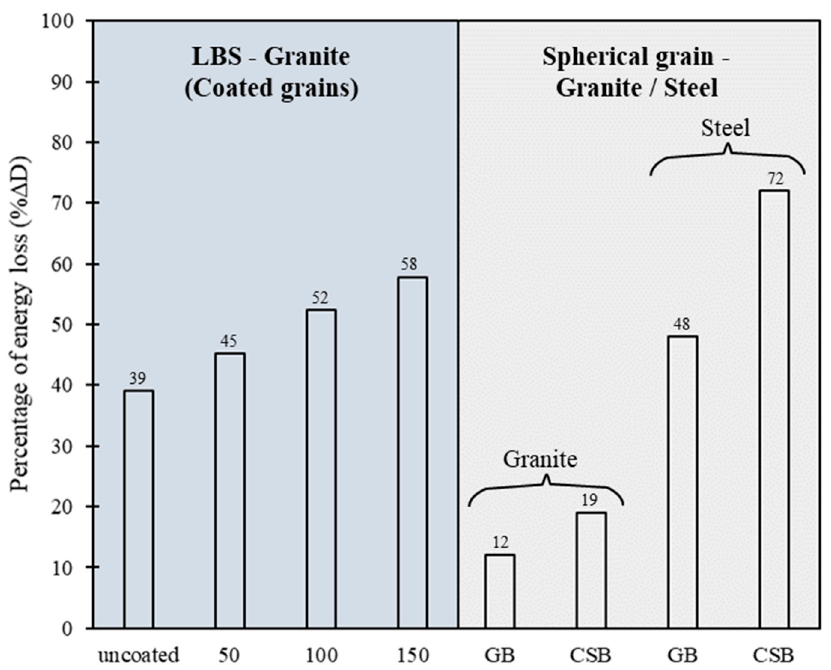
Figure 11. Histograms of percentage energy loss for various grain and block combinations (results on spherical grains of glass beads (GB) and chrome steel balls (CSB), after [42]).